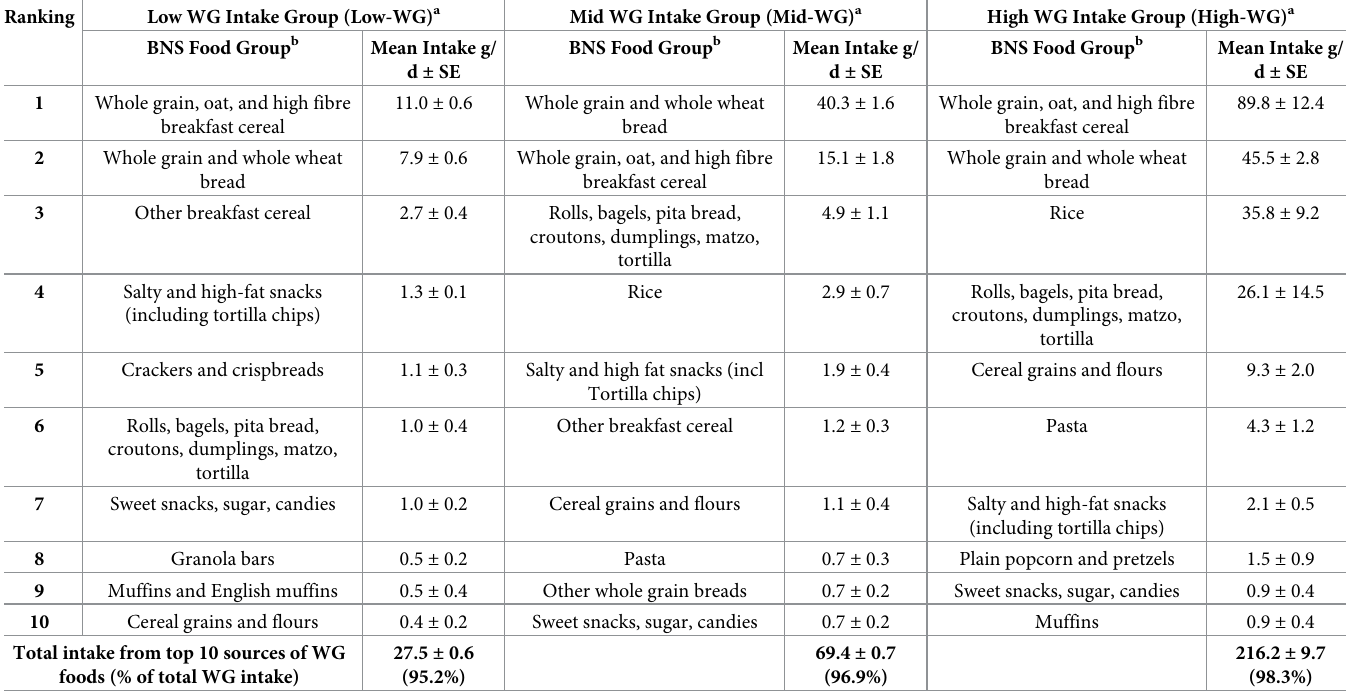
Table 5. Top ten food sources of whole grain for Canadian adults stratified by whole grain intake.